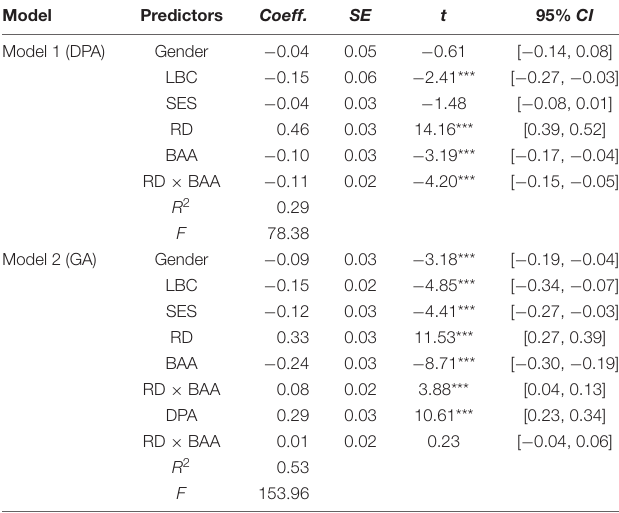
TABLE 2 | Testing the moderated mediation effects of relative deprivation on left-behind children’s game addiction.